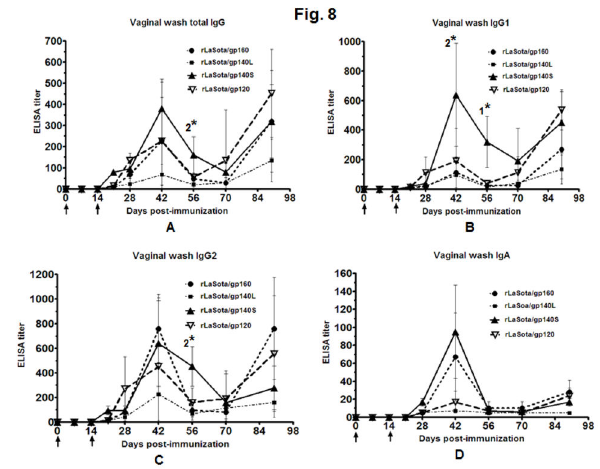
Figure 7. NDV-specific total IgG (panel A), and HIV-1 gp120-specific total IgG (panel B), IgG1 (panel C) and IgG2 (panel D) responses in guinea pig sera. The guinea pigs were immunized with the indicated rNDVs by the i.n. route. (A) The guinea pig sera were analyzed for NDV-specific antibodies by commercial NDV ELISA kits (Synbiotics Corporation). Mean ELISA end-point titers of NDV-specific serum antibodies on days 28 and 56 are shown. (B-D) The guine pig sera were analyzed by HIV-1 gp120 specific total IgG, IgG1 and IgG2 antibodies by isotype-specific ELISA with purified gp120. Mean ELISA end-point titers of gp120-binding serum antibodies of the indicated isotype on days 0, 7, 14, 21, 28, 42, 56, 70 and 90 are shown. Antibodies specific to gp120 were not detected in any animal on any day in the control rLaSota group. The graph shows the geometric mean value ± SEM for 3 animals in rLaSota, rLaSota/gp160 and rLaSota/gp140L groups, 6 animals in rLaSota/gp140S group and 5 animals in rLaSota/ gp120 group. Arrows indicate time of rNDV immunizations on days 0 and 14. Statistical differences between the groups were calculated by unpaired t test (two-tailed). 1* indicates statistically significant differences ( P <0.05) of rLaSota/gp140S vs. rLaSota/gp160, rLaSota/gp140L and rLaSota/gp120 groups. 2* indicates statistically significant differences ( P <0.05) of rLaSota/gp140S vs. rLaSota/gp160 and rLaSota/gp140L groups. doi: 10.1371/journal.pone.0078521.g007 response induced in rLaSota/gp140S group was significantly higher compared to rLaSota/gp160 rLaSota/gp140L groups ( P <0.05), whereas on day 56, it was significantly higher in this group compared to all the other groups ( P <0.05). Also the IgG2a response induced on day 56 in rLaSota/gp140S group was significantly higher compared to rLaSota/gp160 and rLaSota/gp140L groups ( P <0.05). The vaginal IgG1:IgG2a ratio varied from 1: 3 to 1:7 at different time points for the rLaSota/ gp160 group, indicative of a Th1-biased response. In the other groups, the vaginal Th1:Th2a ratio varied at different time points from 1:0.7 to 1:4.5, 1:0.6 to 1:2.3 and 1:1 to 1:4 for rLaSota/gp140L, rLaSota/gp140S, and rLaSota/gp120, indicative of a mixed Th1/Th2a response. BaL.1 gp120-specific